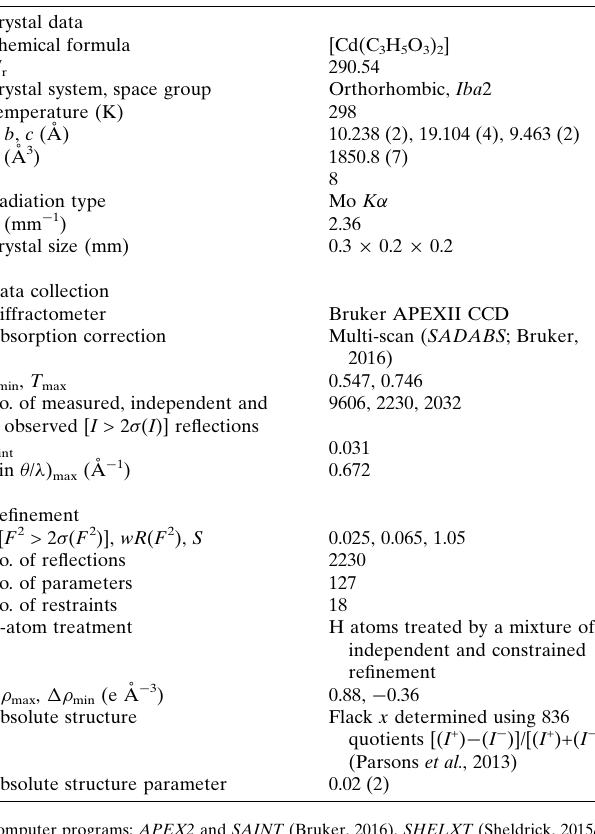
Table 1 Hydrogen-bond geometry (A˚ , (cid:5) ).